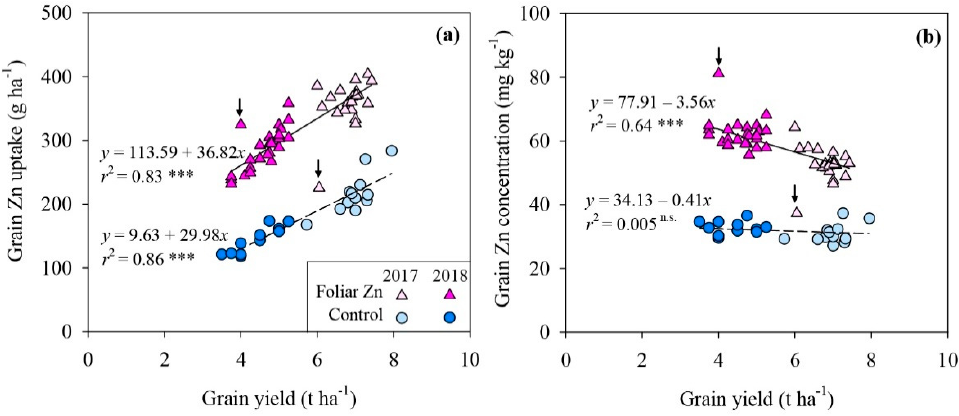
Figure 4. The correlation analysis of grain Zn uptake ( a ) and concentration ( b ) against grain yield in wheat with nil Zn application (control) and foliar Zn spray (with and without pesticides). The arrow pointing data were removed from the trend-line to give a higher r 2 . ***, p < 0.001; n.s., not significant.